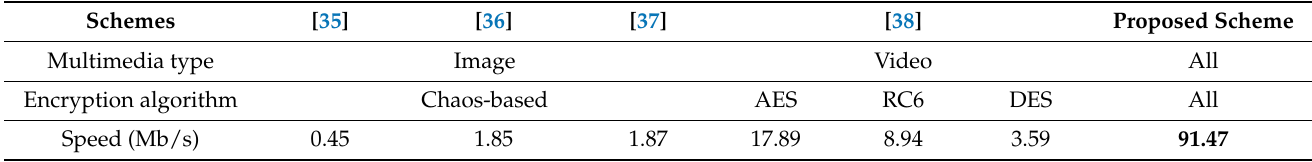
Table 3. Decryption speed